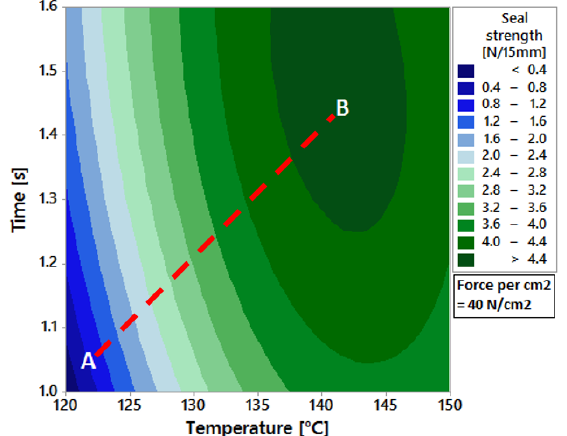
Figure 8 – Contour plot of Seal strength vs. Time and Temperature.